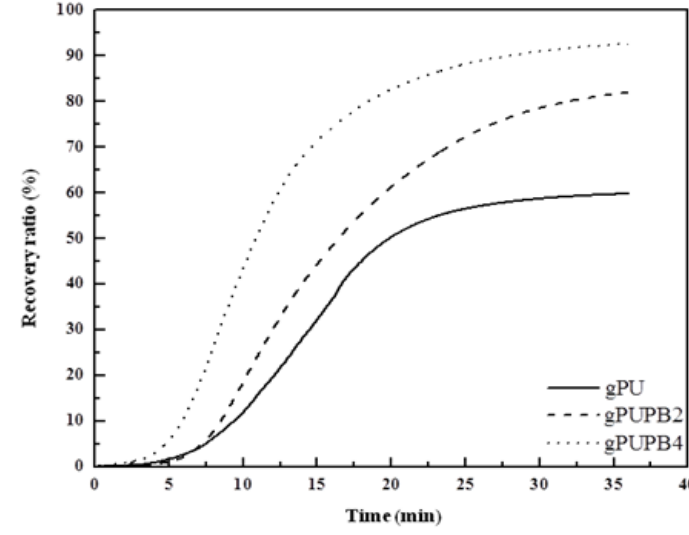
Figure 6. Shape recovery ratio as a function of time. Samples were heated from fixing temperature to respective T at a heating rate of 5 °C min − 1 and kept isothermal trans for 20